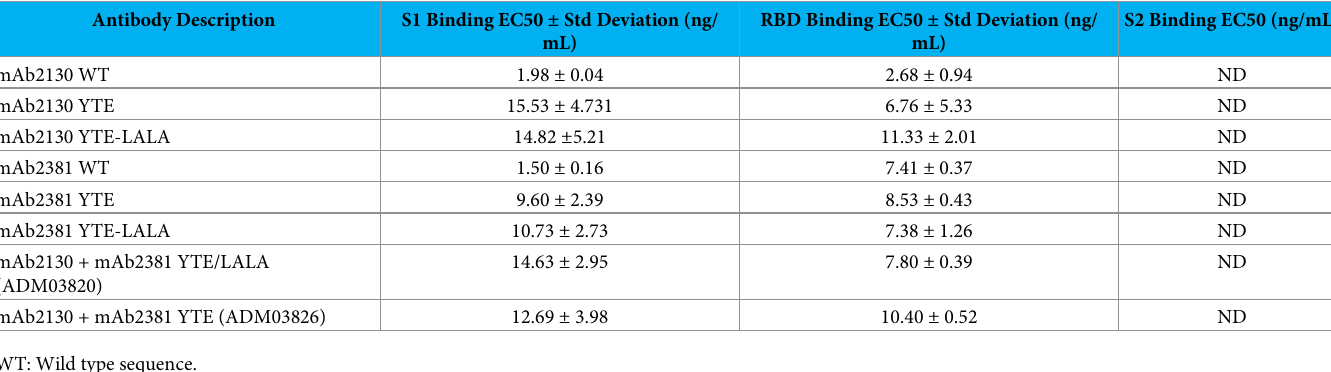
Table 2. ELISA binding results to different spike protein variants. Antibody